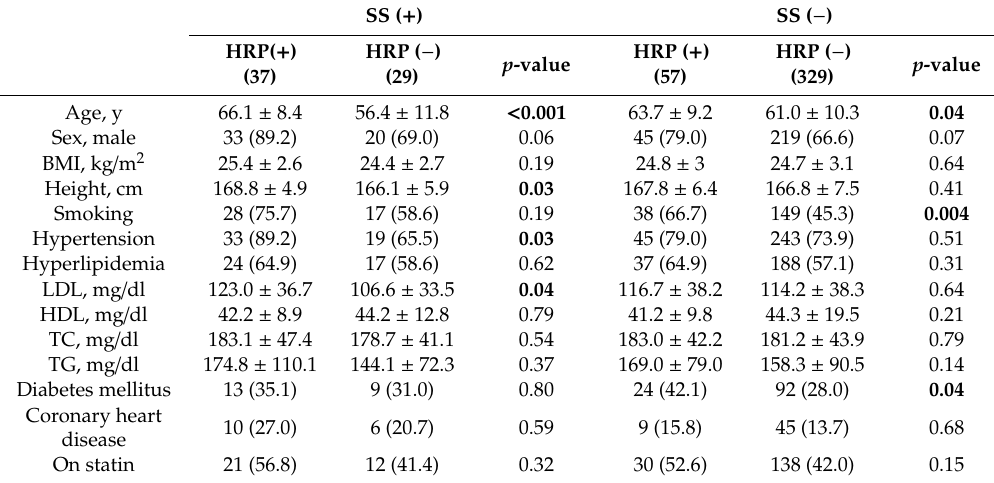
Table 1. Clinical characteristics of 452